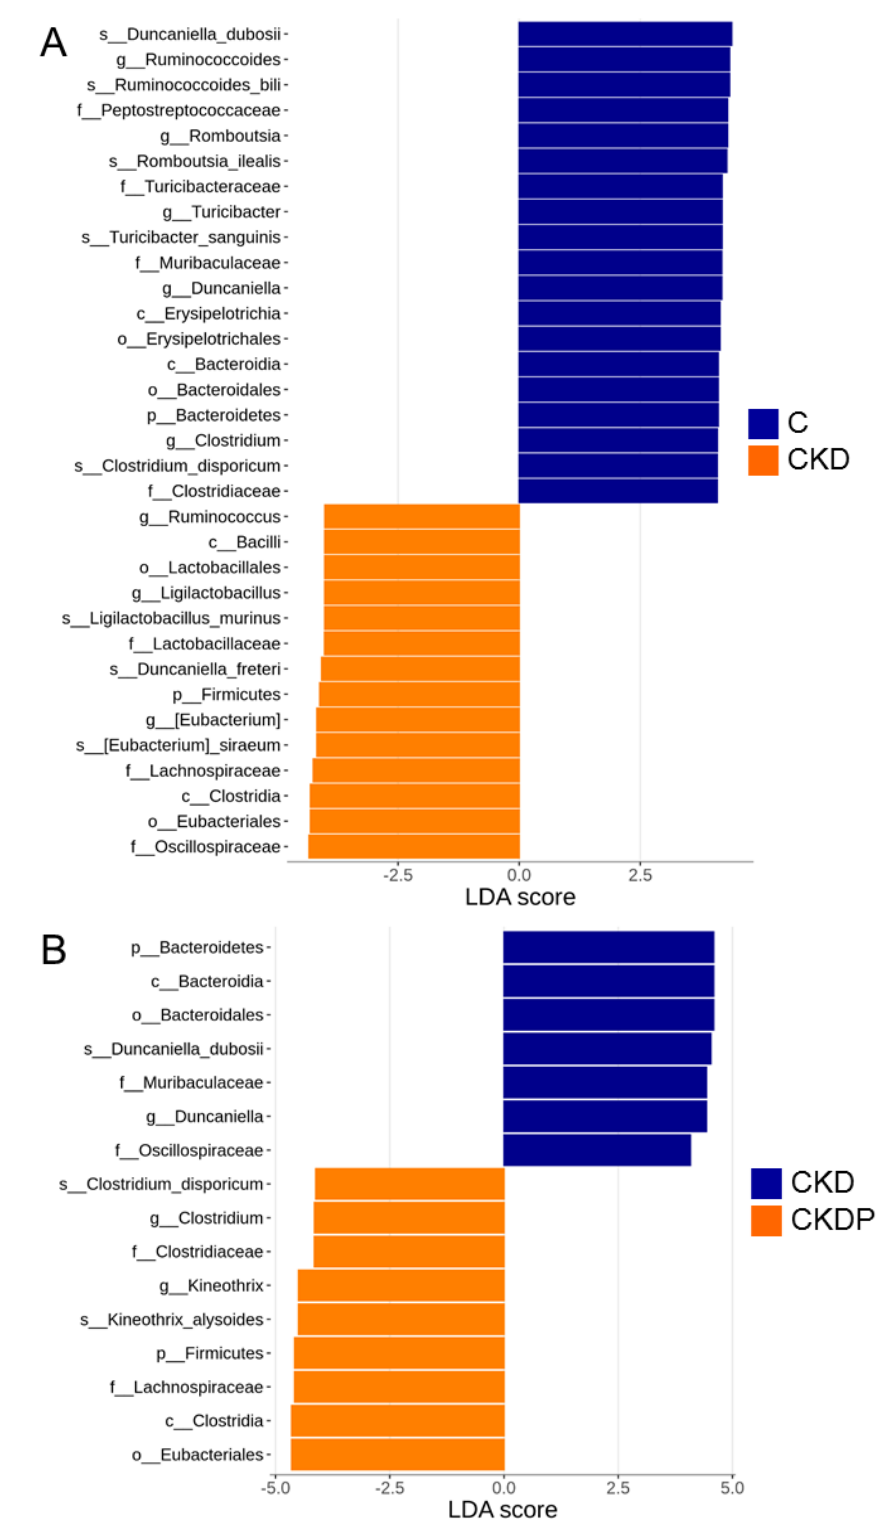
Figure 6. Linear discriminant analysis effect size (LEfSe) showing the most differentially abundant bacterial taxa between ( A ) the C and CKD group and ( B ) the CKD and CKDP group of offspring at the age of 12 weeks. The linear discriminant analysis (LDA) score threshold was set to greater than 4.